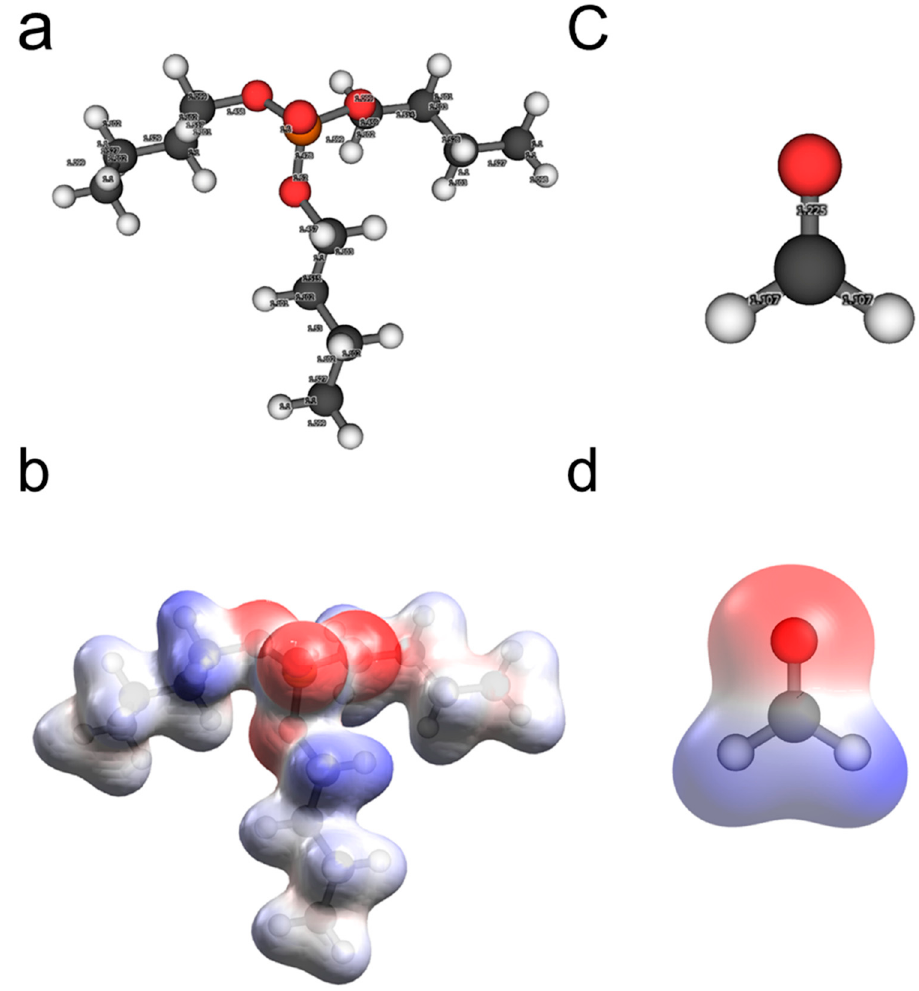
Figure 1. ( a , c ) Optimized structures for TBP and CH 2 O molecules. ( b , d ) ESP mapped on an isosurface with 0.004 a.u. of electron density for TBP and CH 2 O molecules. Note that color coding is used to represent the different values of the electrostatic potential; high ESP values are represented by blue color, and low ESP values are shown in red color, while white color represents the region of zero potential. White atoms are hydrogen; gray atoms are carbon; red ones are oxygen, and the yellow atom is phosphorus.